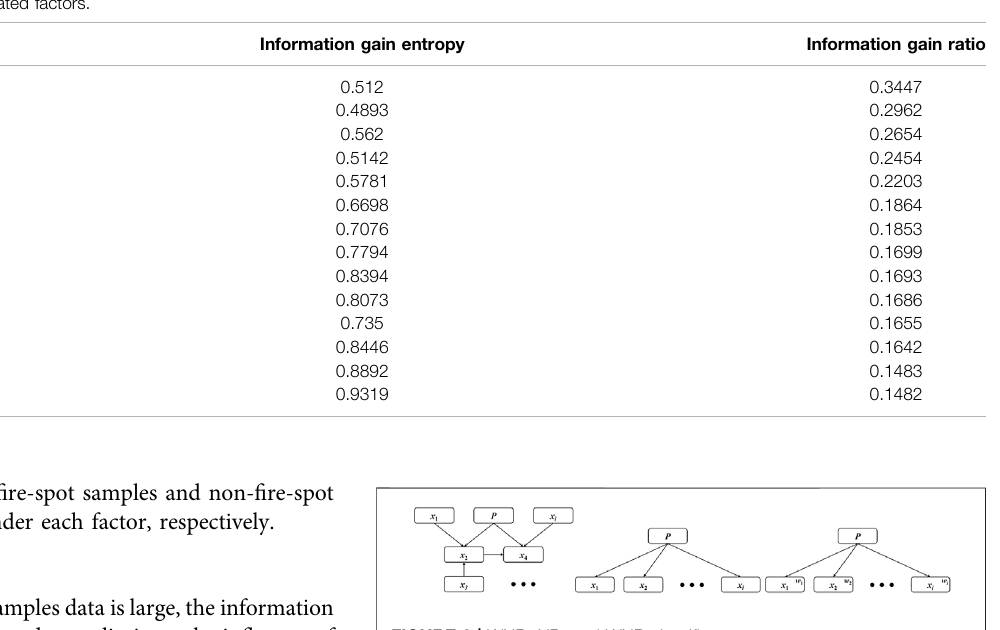
FIGURE 3 | WNB, NB, and WNB classi fi er